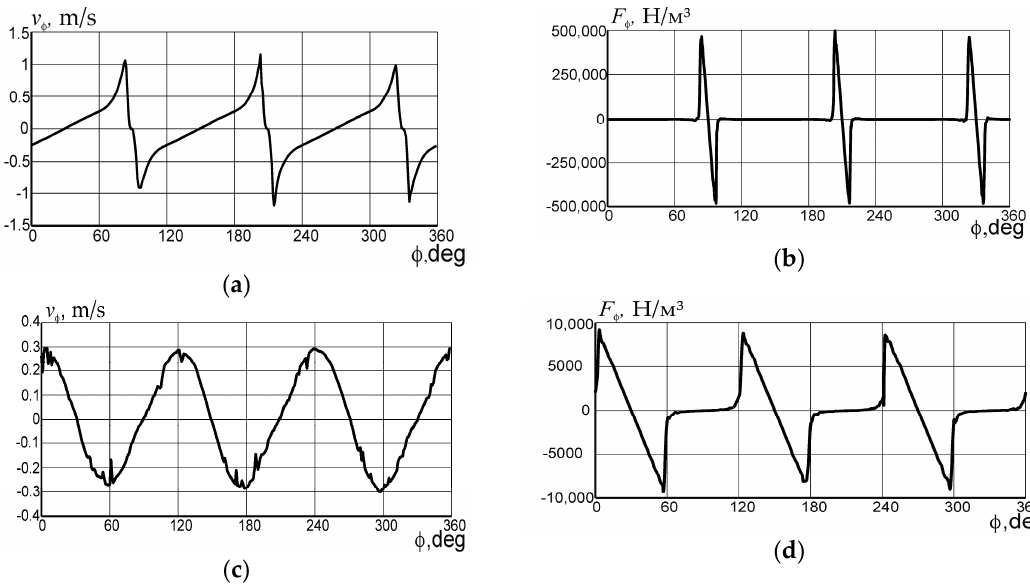
Figure 9. Comparison of the graphs of azimuthal velocity components and electromagnetic forces: ( a , b ) with Z = − 70 mm; ( c , d ) with Z = − 1320 mm.